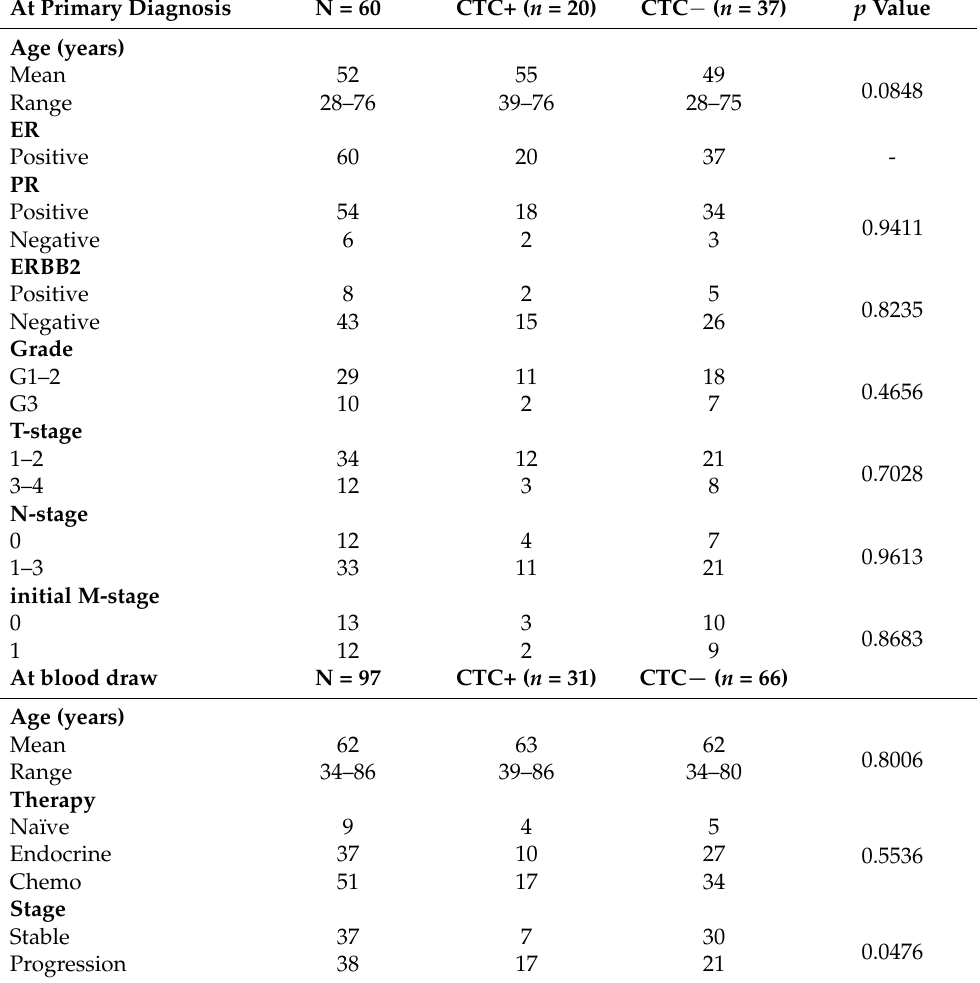
Table 1. Demographic statistics. Number of CTC-positive (CTC+) and CTC-negative (CTC-) blood samples divided according to clinical variables of the patients at primary diagnosis. p -values were calculated using Welch’s two-sided t -test and the multinomial exact test. CTC values were not available for three